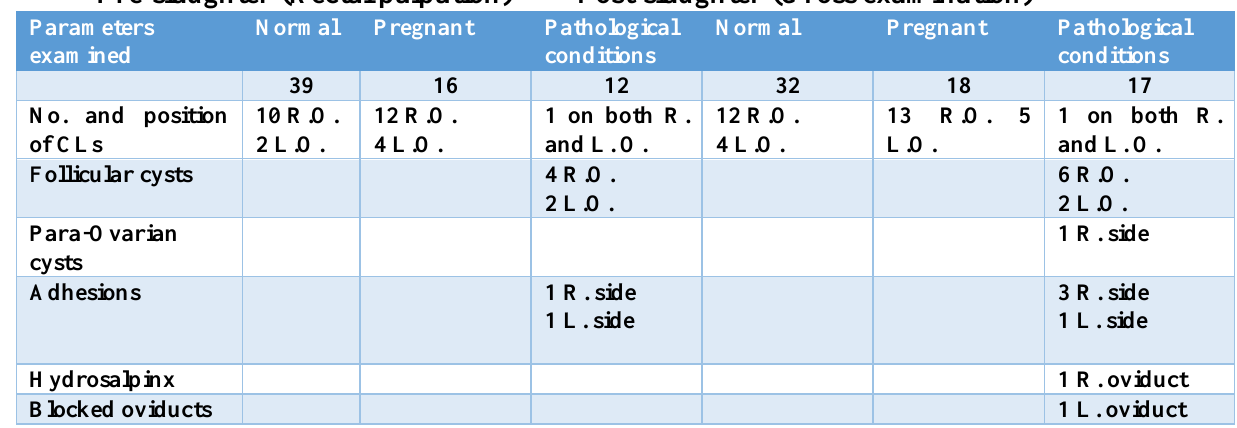
Table, 4: Pre and post slaughter findings in examination of the ovaries and oviducts. Pre-slaughter (Rectal